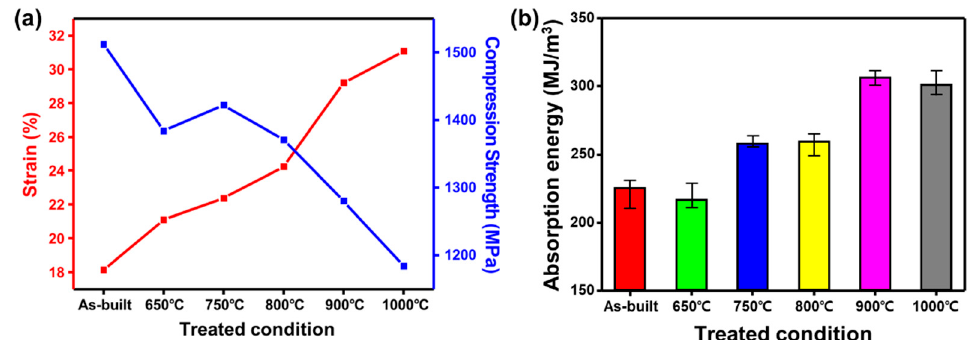
Figure 7. ( a ) Strain, compressive strength, and ( b ) deformation energy after fracture in different SLM Ti ‐ 6Al ‐ 4V specimens.